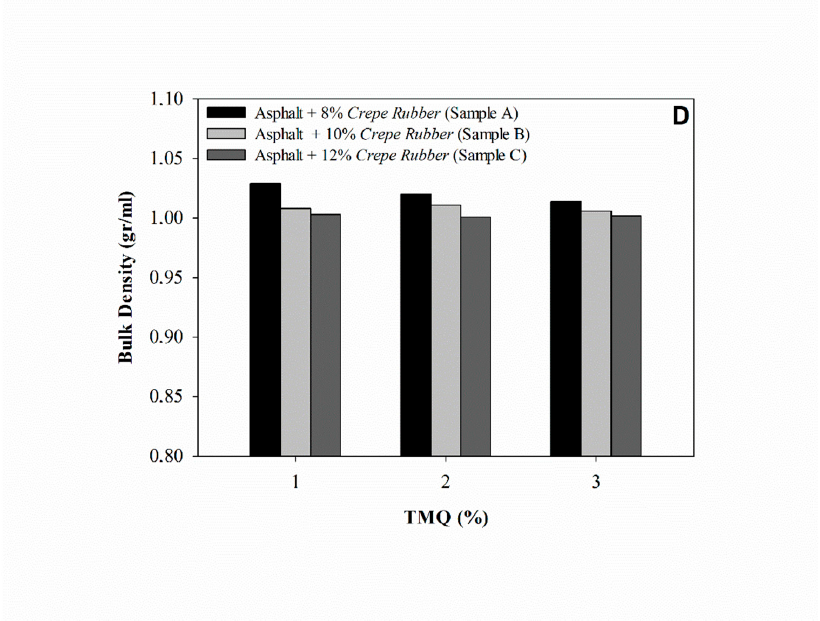
Figure 7. ( A ) VFA. ( B ) VMA. ( C ) VIM. ( D ) Bulk density modification asphalt.